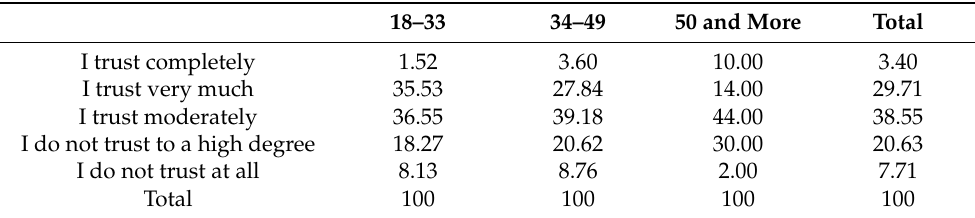
Table 14. Confidence in robots collaborating with humans on the job vs. age in % (N =